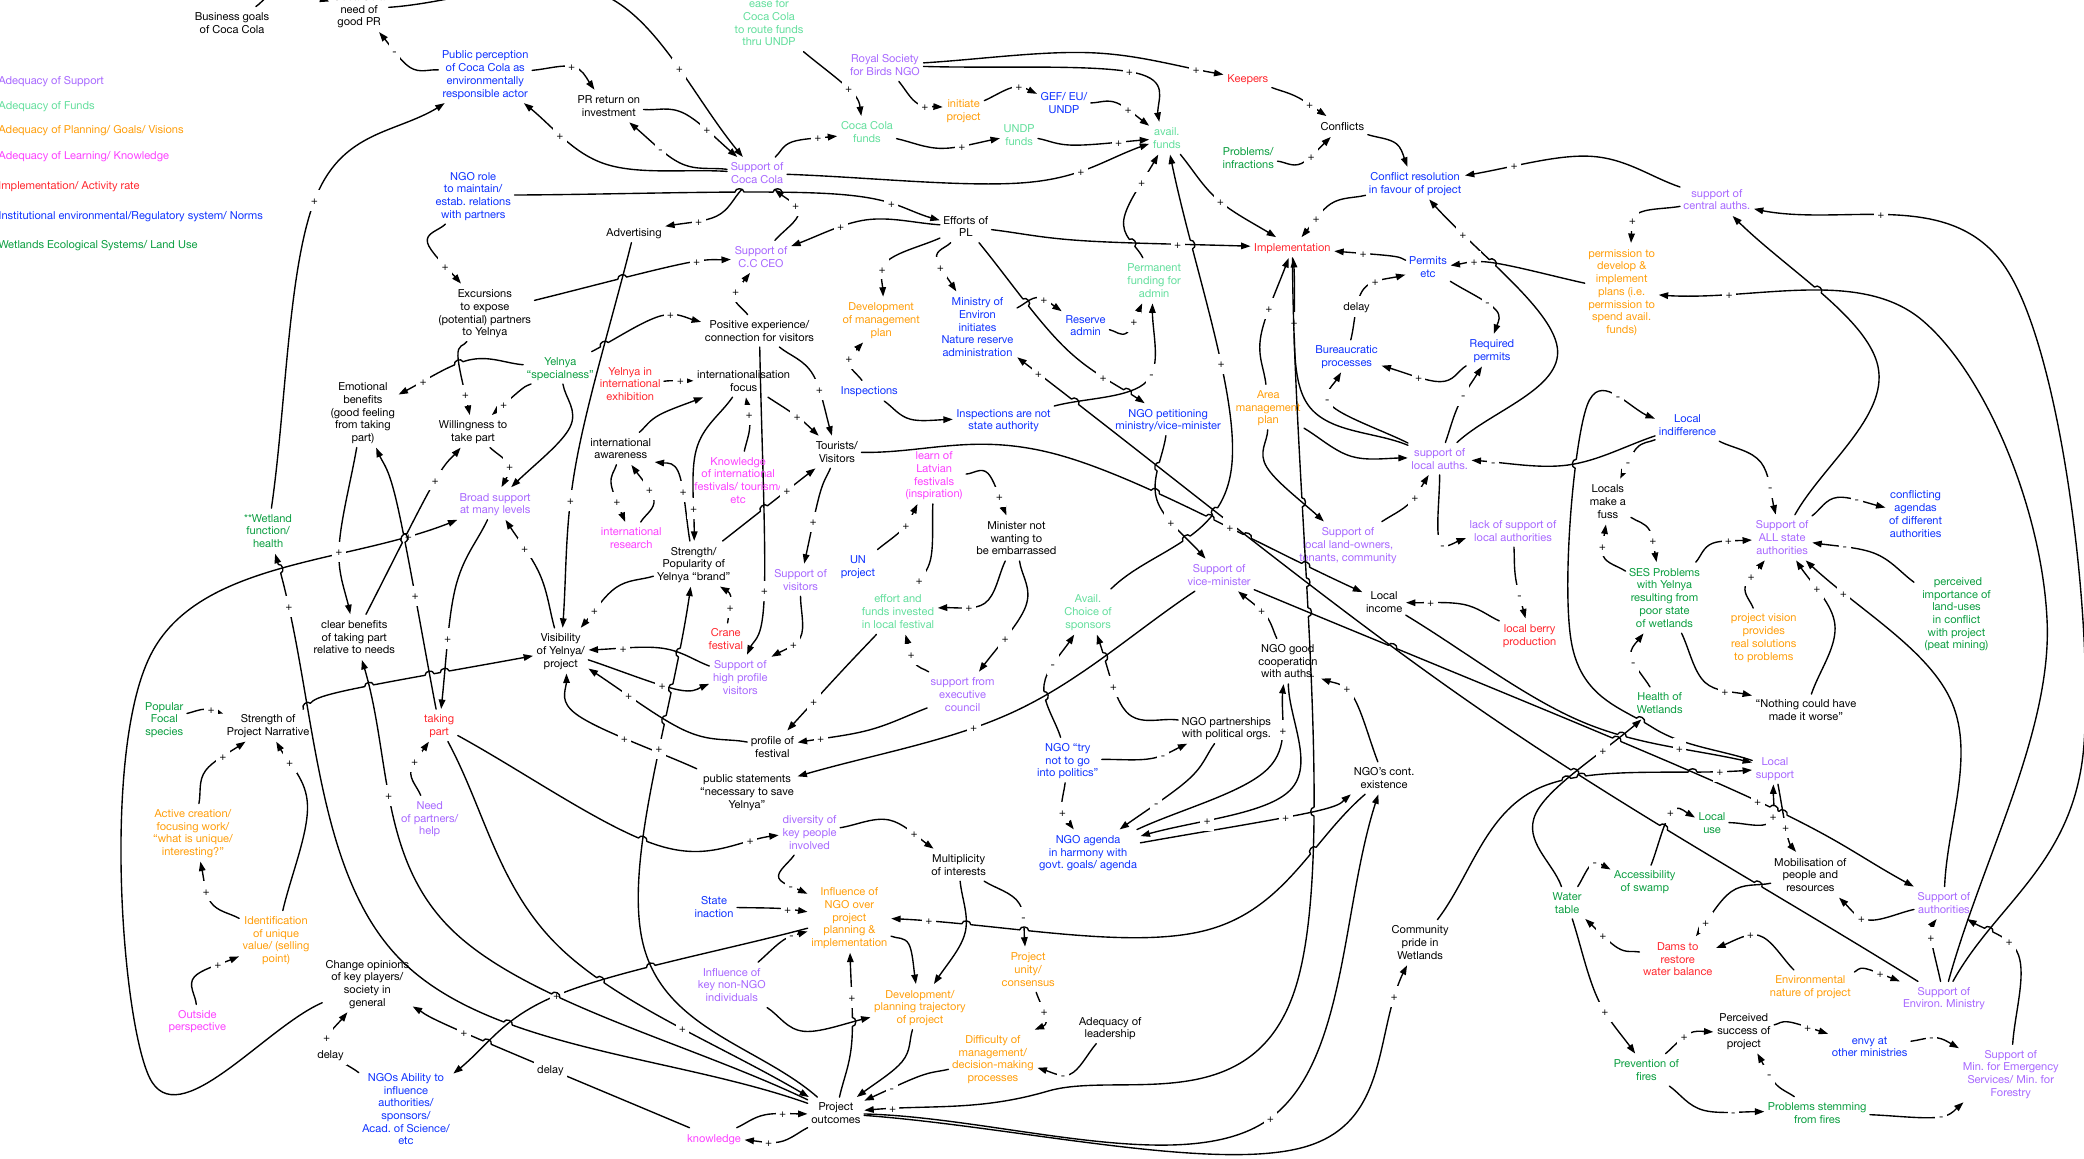
Figure A2:5. Case Bogs, Theme: